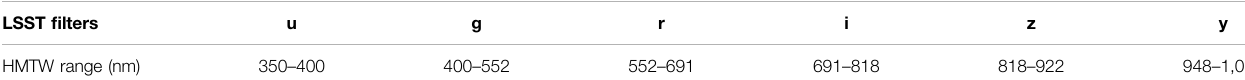
TABLE 1 | The six photometric fi lters used in the LSST survey, and their half-maximum transmission wavelength (HMTW) ranges. LSST fi lters